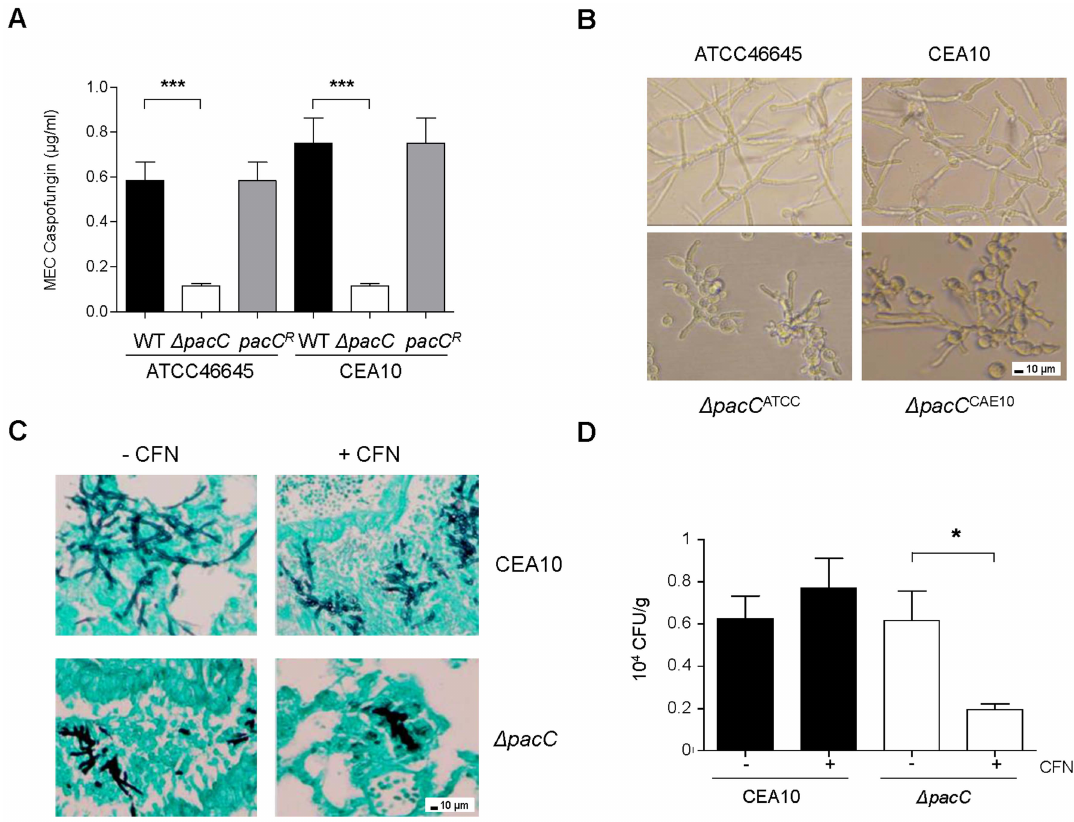
Figure 8. D pacC mutants are hypersensitive to cell wall active drugs. (A) In vitro susceptibility testing to caspofungin (CFN). Determination of CFN MEC ( m g/ml), twice in triplicates, 1.25 6 10 5 spores, 48 hr. (B) A. fumigatus growth in the presence of 16 m g/ml CFN. 400 6 magnification. (C) Histopathology from leukopenic mice infected with CEA10 or D pacC CEA10 (3 6 10 4 spores) in the presence or absence of 5 mg/kg CFN. Lungs sections at 24 hr of infection, GMS and light green staining, 200 6 magnification. (D) In vivo susceptibility testing to caspofungin. Fungal burden at 48 hr of infection, calculated by CFUs, from leukopenic mice infected as from C. Results are expressed as CFUs per gram of lung tissue. A and D: unpaired t test, *** p , 0.001, **.001 , p , 0.01, and * 0.01 , p ,